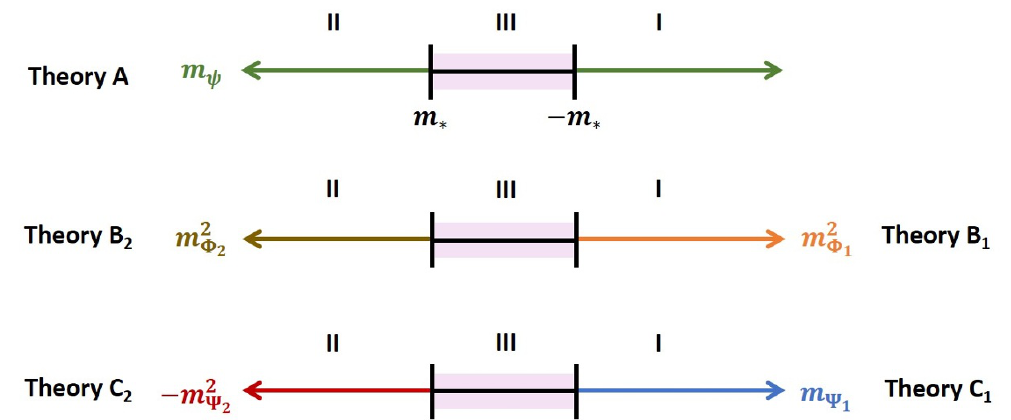
Figure 5 . Phase diagram of the two-node quiver with explicit Z 2 symmetry. Distinct theories are shown in di(cid:11)erent colors. Note the splitting of the bottom two phase diagrams which results from the use of the (cid:13)avor-violated 3d bosonization